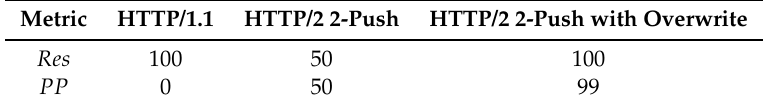
Table 3. Total number of requests and PUSH_PROMISE frames capturing on the client’s device.